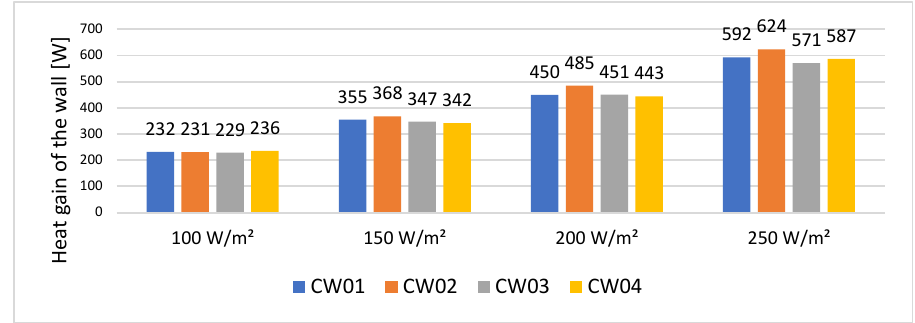
Figure 8. Heat gain of the wall.